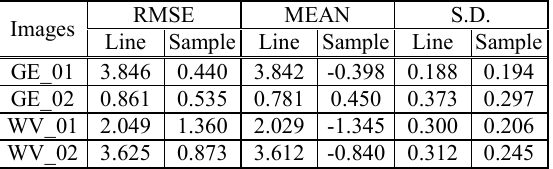
Table 2. Biases of the